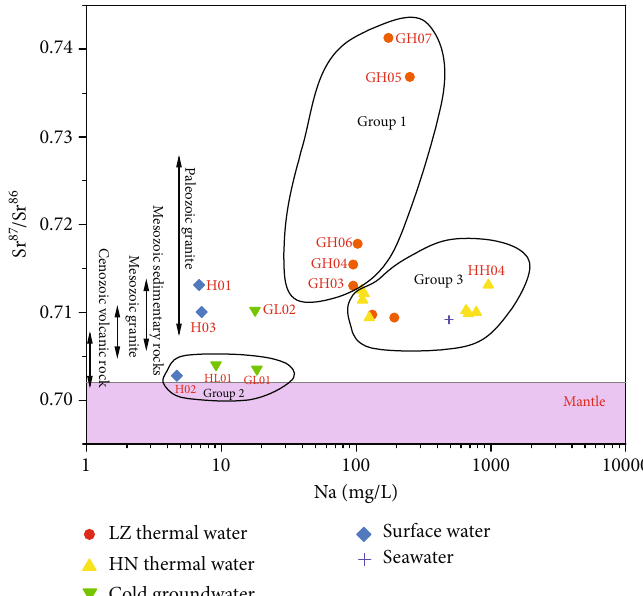
Figure 6: Relations between 87 Sr/ 86 Sr and Na of thermal water in the study area, and the isotope references for rocks and mantle are cited from [31 –